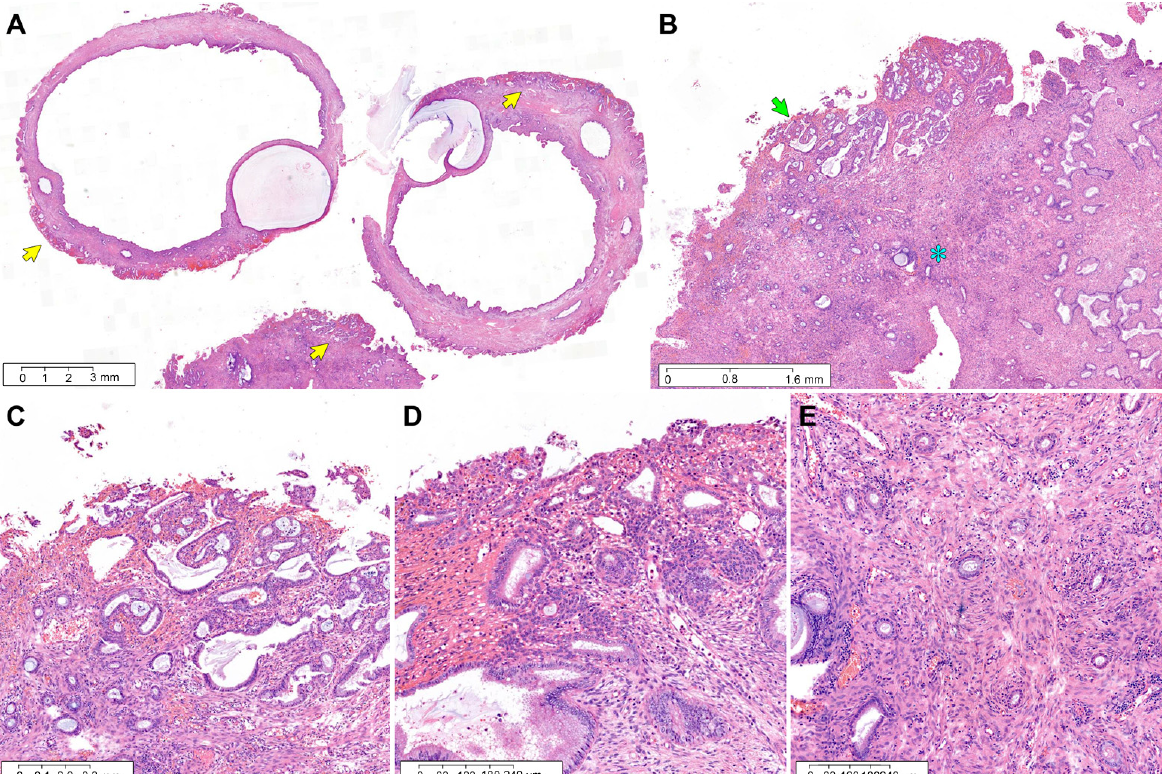
Figure 6. SM involving ECP. ( A ) ECP of case 1 reveals areas of SM and reactive glandular proliferation (yellow arrows). Some cystically dilated glands are present. ( B ) In addition to the immature SM (green arrow), small glands are embedded in the fibrotic stroma (blue asterisk). ( C ) The endocervical glands in SM lesions vary in size and shape. ( D ) Metaplastic squamous epithelium possesses small, bland nuclei and scant cytoplasm and grows beneath the pre-existing endocervical epithelium. There is no complex glandular proliferation, solid architecture, cribriforming, or high-grade cytological atypia. ( E ) The stroma exhibits fibrosis and mixed chronic inflammatory infiltrates. ( A – E ), Hematoxylin and eosin staining. Original magnification: ( A ), 15 × ; ( B ), 40 × ; ( C ), 100 × ; ( D ), 150 × ; ( E ), 120 ×